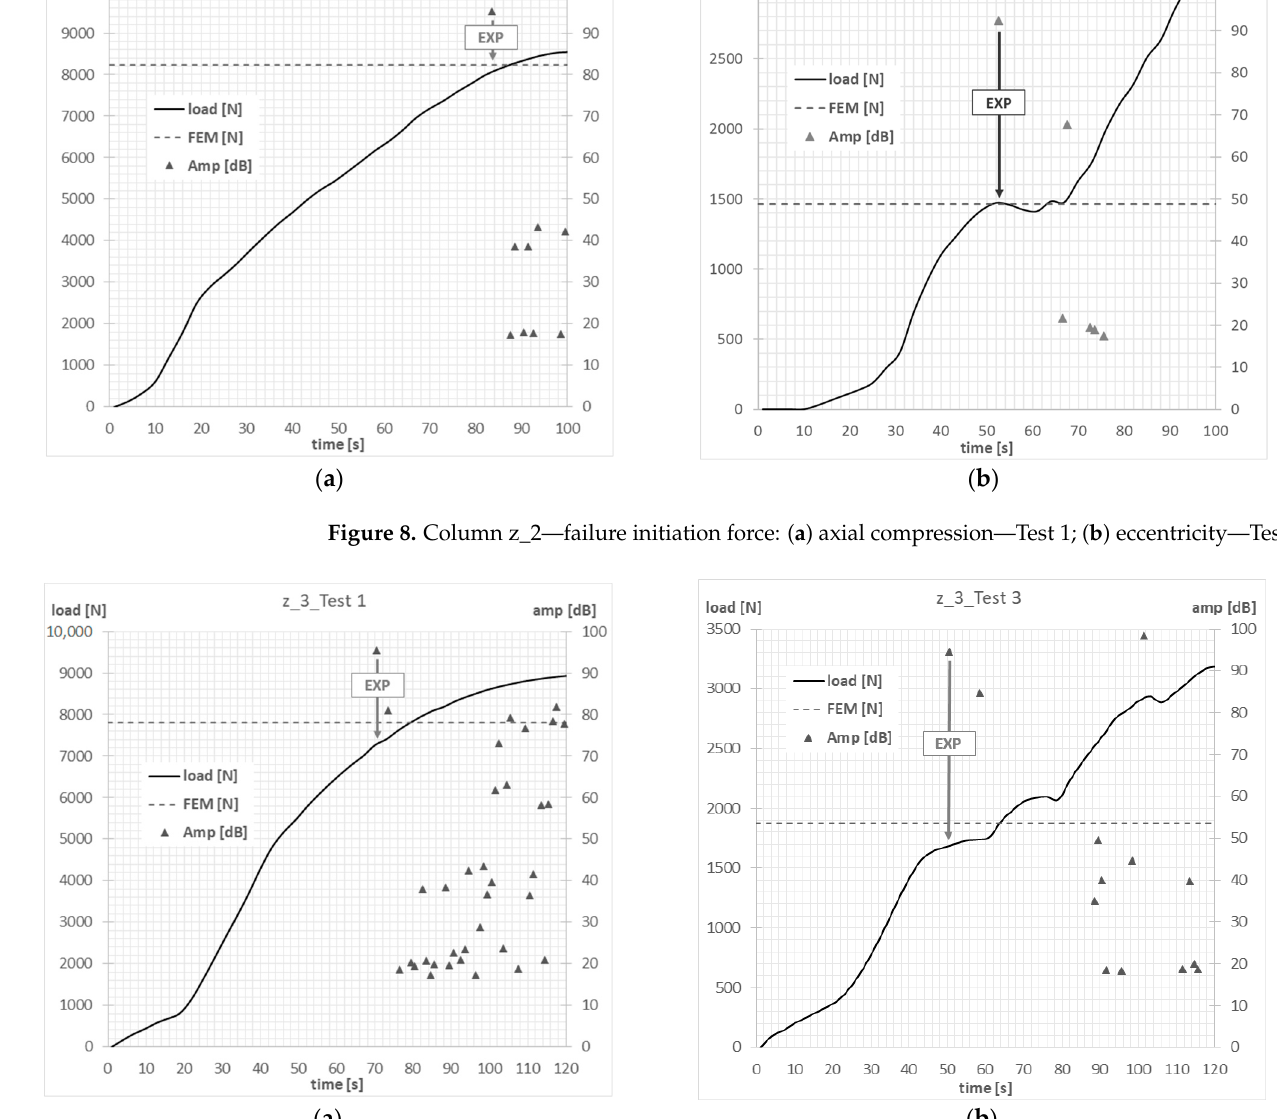
Figure 9. Column z_3—failure initiation force: ( a ) axial compression—Test 1; ( b ) eccentricity—Test 3.